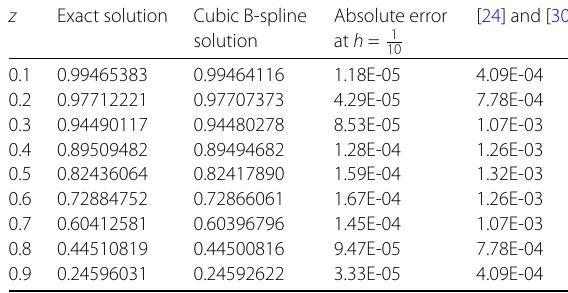
Table 3 Algebraic outcomes for Problem 1 at h = 1 z Exact